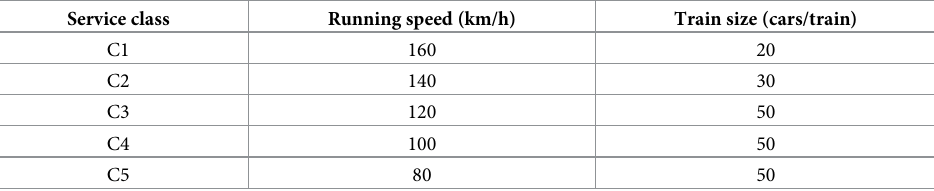
Table 7. Train service